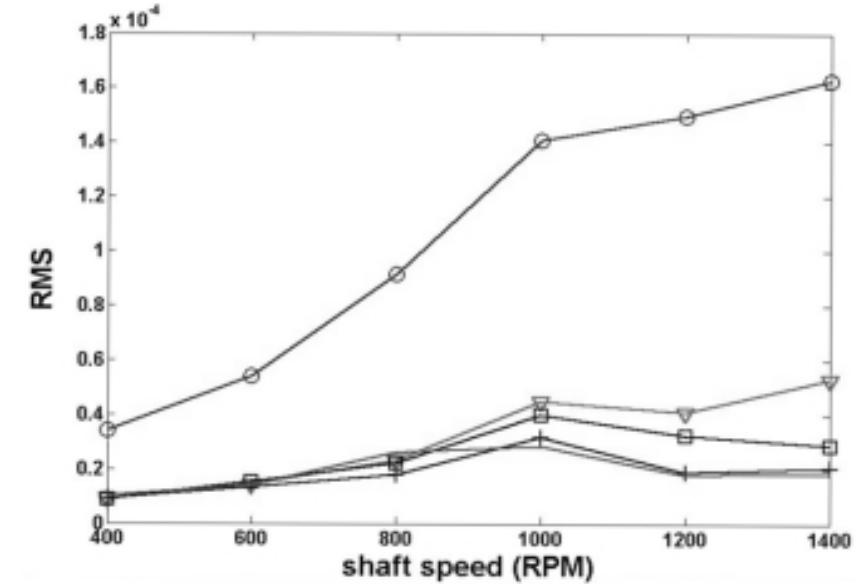
Fig. 6. RMS of the velocity signal as a function of the rotating shaft speed, load